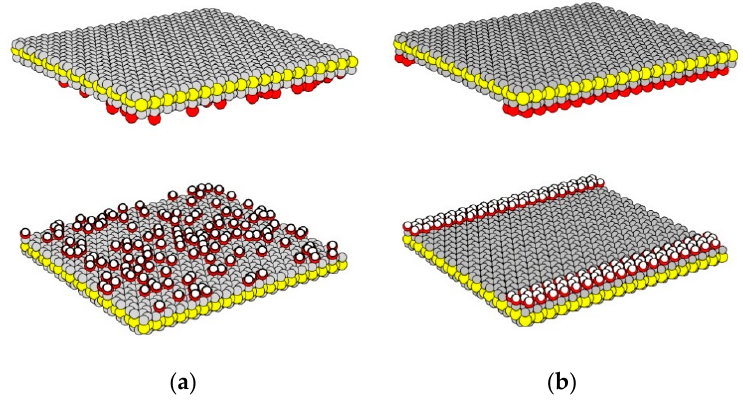
Figure 3. Two proposed models for OH groups presenting on the inner walls of porous silica surfaces ( a ) the random and ( b ) the fixed topologies. In the figures, the yellow spheres represent the silicon atoms and the grey spheres represent the oxygen atoms of SiO 4 . The red spheres and small white spheres represent the oxygen and hydrogen atoms of the OH functional